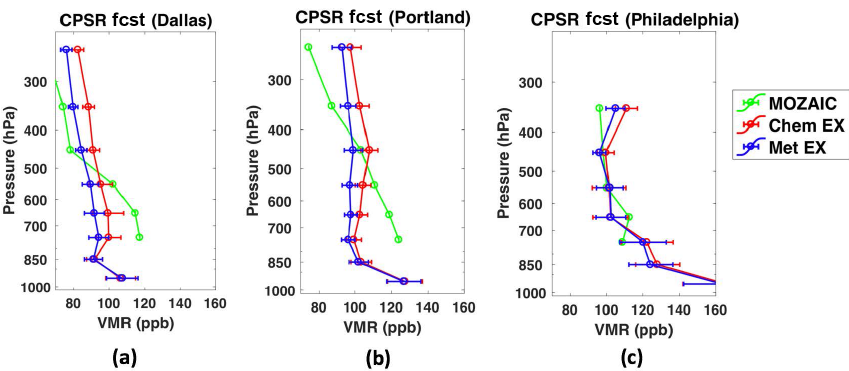
Figure 2. Comparisons of the CPSR experiment against the IAGOS/MOZAIC in situ CO profiles in ppb composited for 1 June 2008 for Dallas, TX, in panel (a) , 3 and 9 June 2008 for Portland, OR, in panel (b) , and 7 June 2008 for Philadelphia, PA, in panel (c) . Chem EX refers to the CPSR experiment. The error bars are based on the ensemble variability.